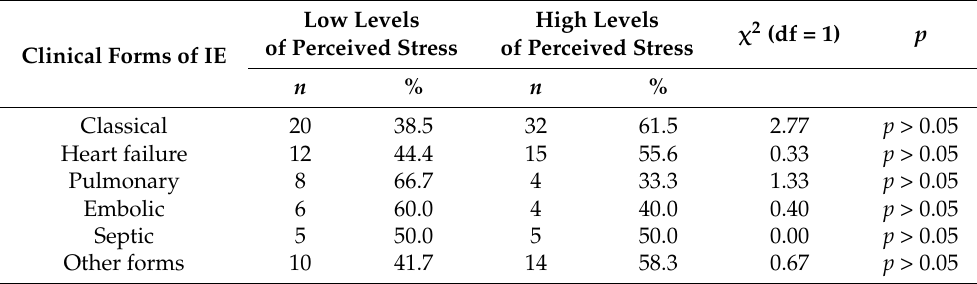
Table 4. The associations between gender, work type, residence area, clinical form of IE and perceived stress among patients with infective endocarditis ( n =